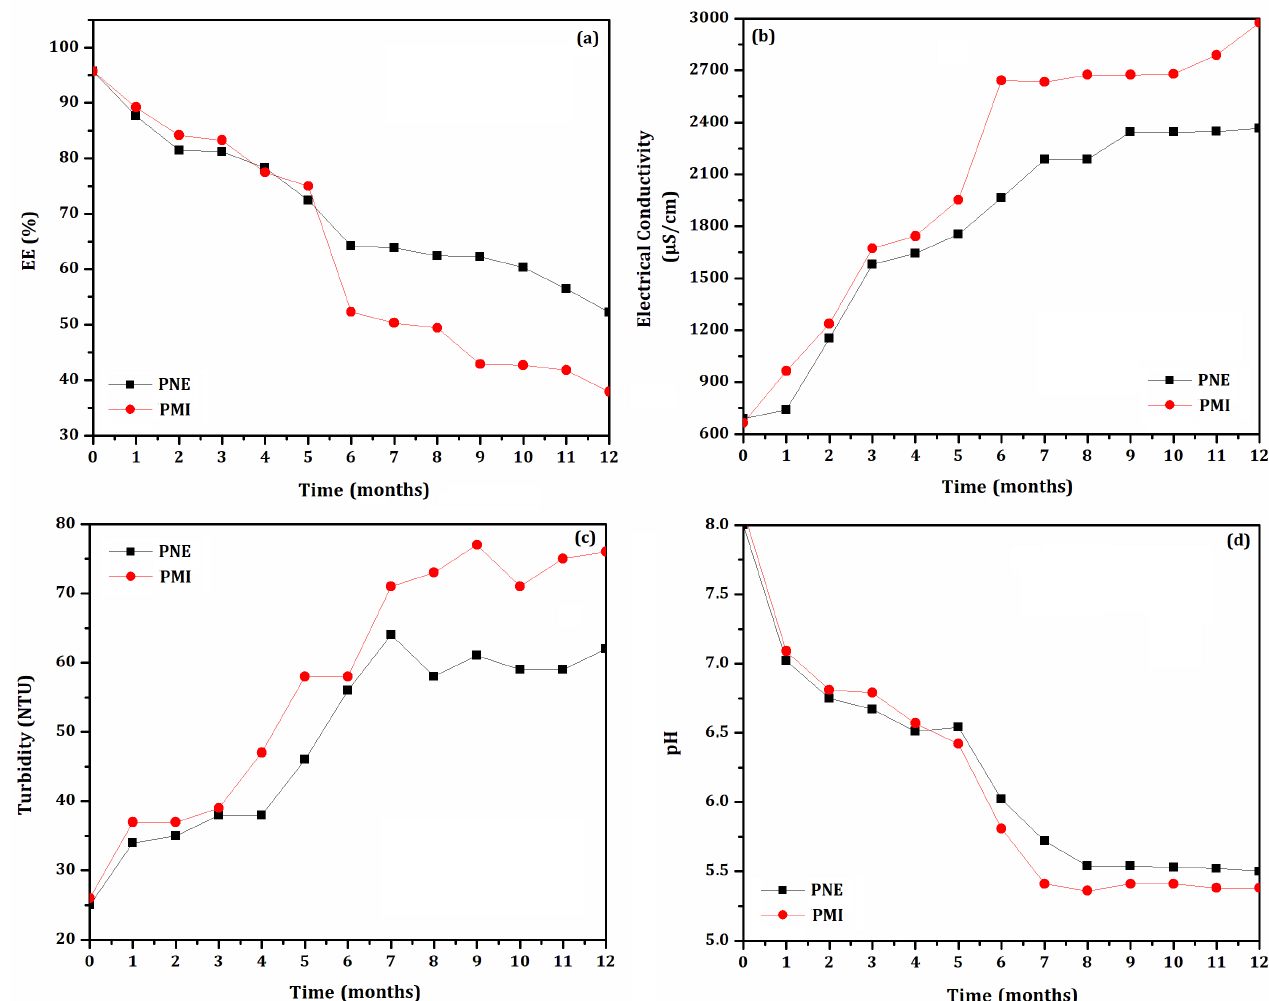
Figure 3. Shelf-life storage evaluation (12 months) of the biodefensives PNE and PMI based on ( a ) Encapsulation Efficiency (EE%), ( b ) electrical conductivity, ( c ) turbidity and ( d )